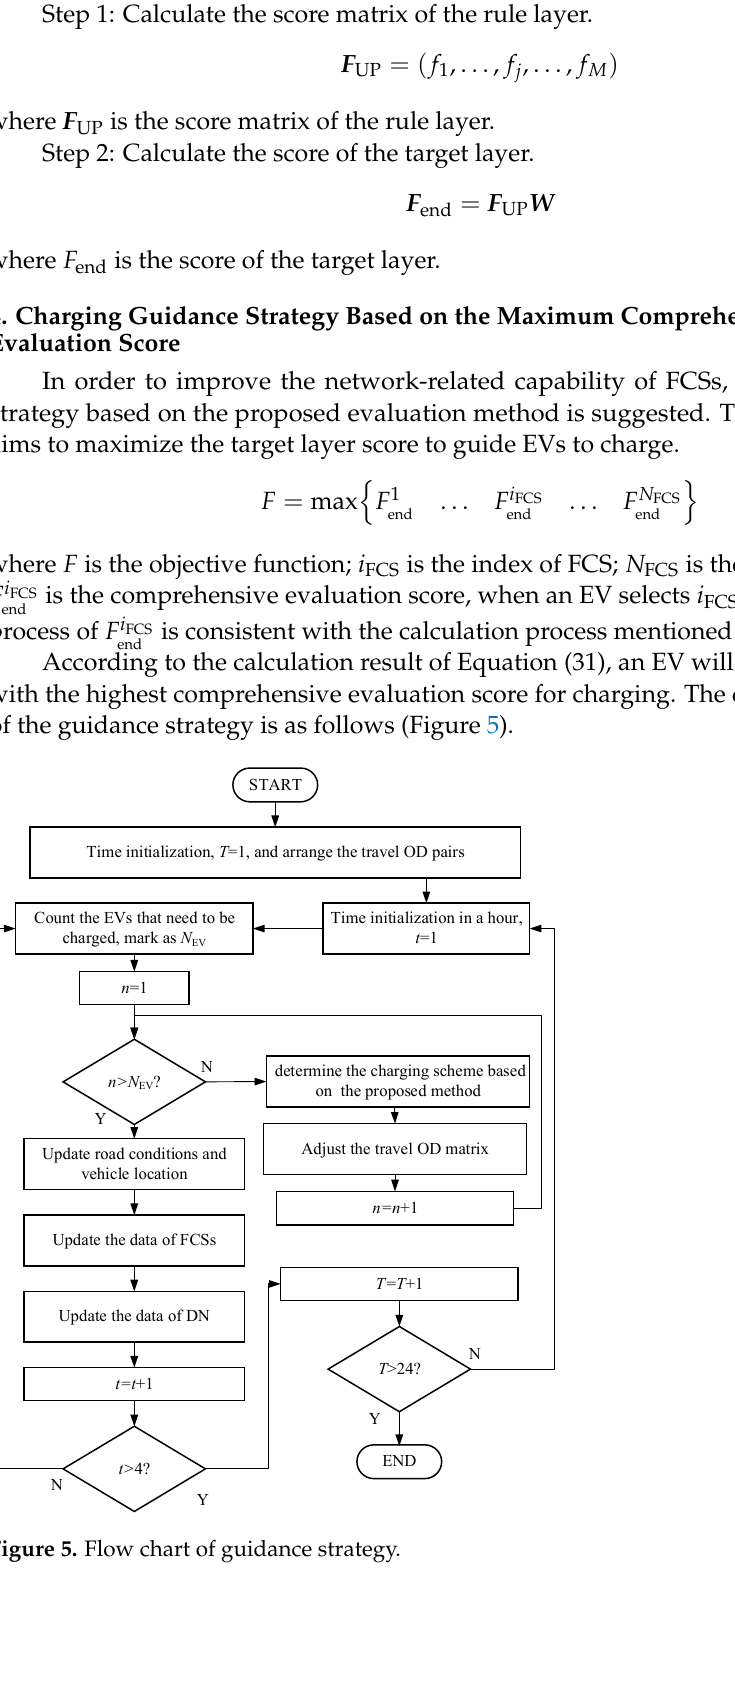
34 Fast charging station Figure 6. Topological structure of road network.